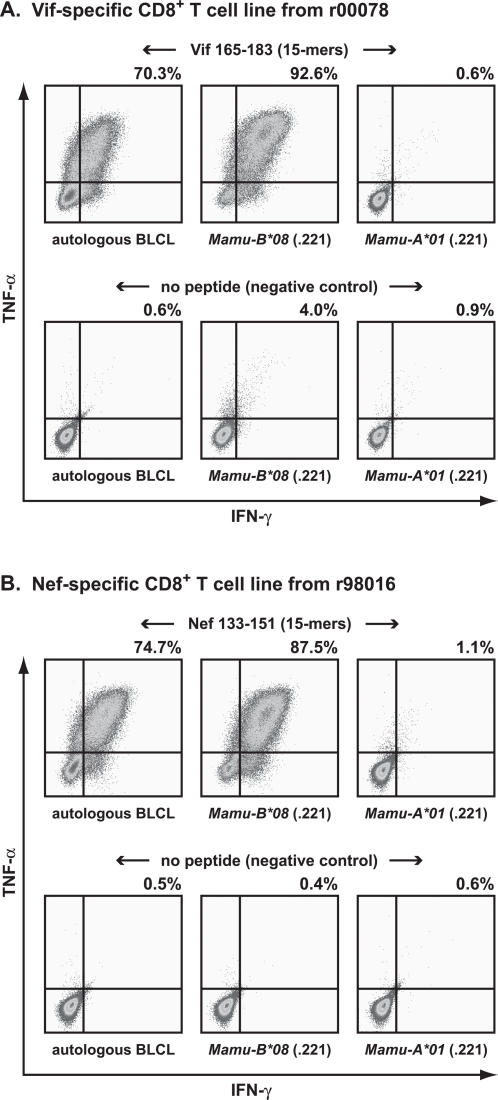
Mamu-B*08 restricts both of the novel SIV-specific CD8+ T cell responses observed in the CD8+ cell-depleted EC macaques.721.221 cells, which do not express endogenous classical MHC class I molecules, were stably transfected with Mamu-B*08 or Mamu-A*01 and pulsed with the appropriate peptides. Peptide-pulsed cells were used in ICS assays with peptide-specific CD8+ T cell lines. CD8+ T cell lines raised against 15-mers derived from A) Vif (positions 165–183) from animal r00078 and B) Nef (positions 133–151) from animal r98016 were stimulated by the Mamu-B*08 stable transfectants pulsed with the relevant peptides. The cytokine reactivity was comparable to levels elicited when autologous BLCL were used as APCs (positive control). No peptide stimulation was observed when using the Mamu-A*01 stable transfectants as APCs (negative control). Negative controls without peptide in the presence of APCs also gave negligible cell stimulation. Percentages over each FACS dot plot signify the maximal cytokine response (total of IFN-γ+ cells, TNF-α+ cells, and IFN-γ+ TNF-α+ cells).